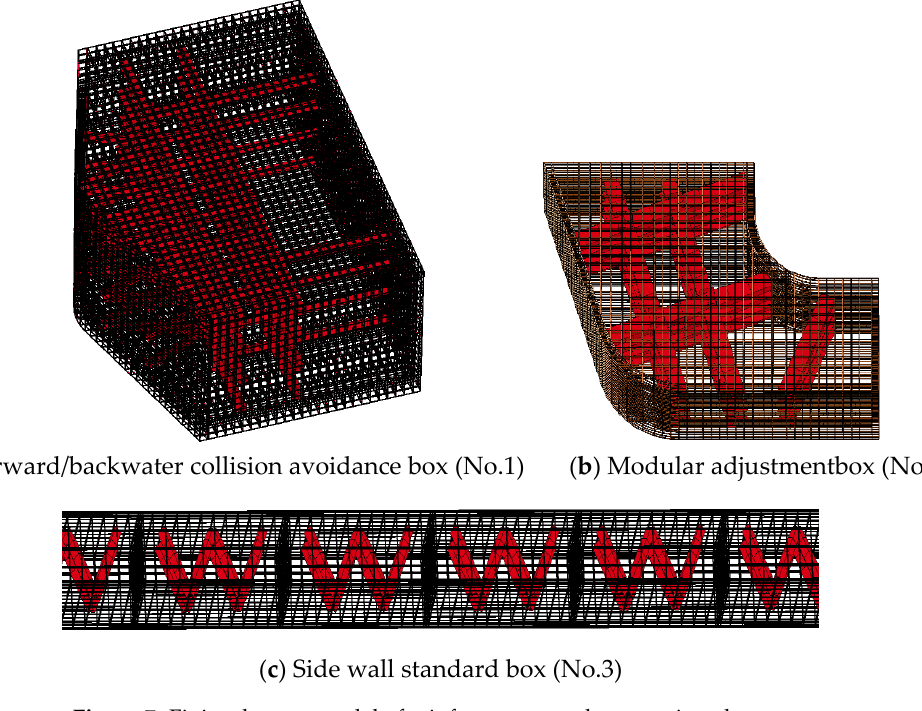
Table 1. Calculation parameters of the C130 concrete HJC (Holmquist-Johnson-Cook) constitutive model.